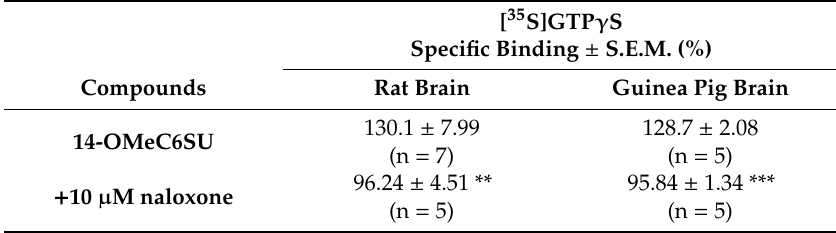
Table 3. Examining the opioid receptor mediation in G-protein activity ([ 35 S]GTP γ S specific binding normalizedtobasalactivity)of14-OMeC6SUinthepresenceorabsenceof10 µ Mnaloxonein[ 35 S]GTP γ S binding assays performed in rat and guinea pig brain membrane homogenates. 14-OMeC6SU was added in 10 and 100 µ M in rat and guinea pig brain membranes,